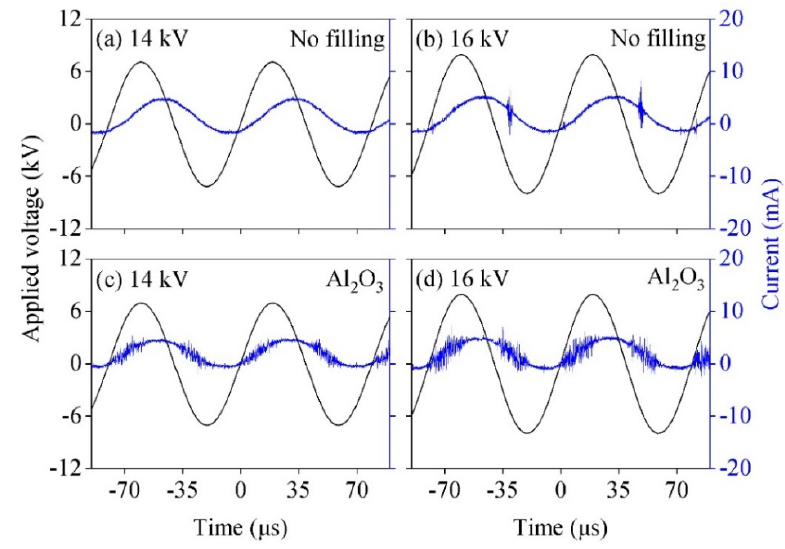
Figure 2. The voltage and current waveforms of discharge in the DBD reactor: ( a ) without a catalyst at 14 kV; ( b ) without a catalyst at 16 kV; ( c ) filled with Al 2 O 3 at 14 kV; ( d ) filled with Al 2 O 3 at 16 kV. (Driving frequency: 12.6 kHz; total gas flow rate: 500 mL/min; discharge gap: 3 mm).